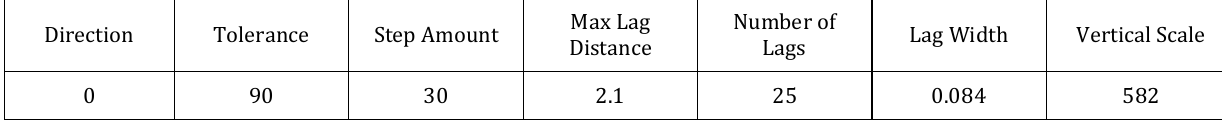
Table 2. Empirical variogram parameters of Grodziec